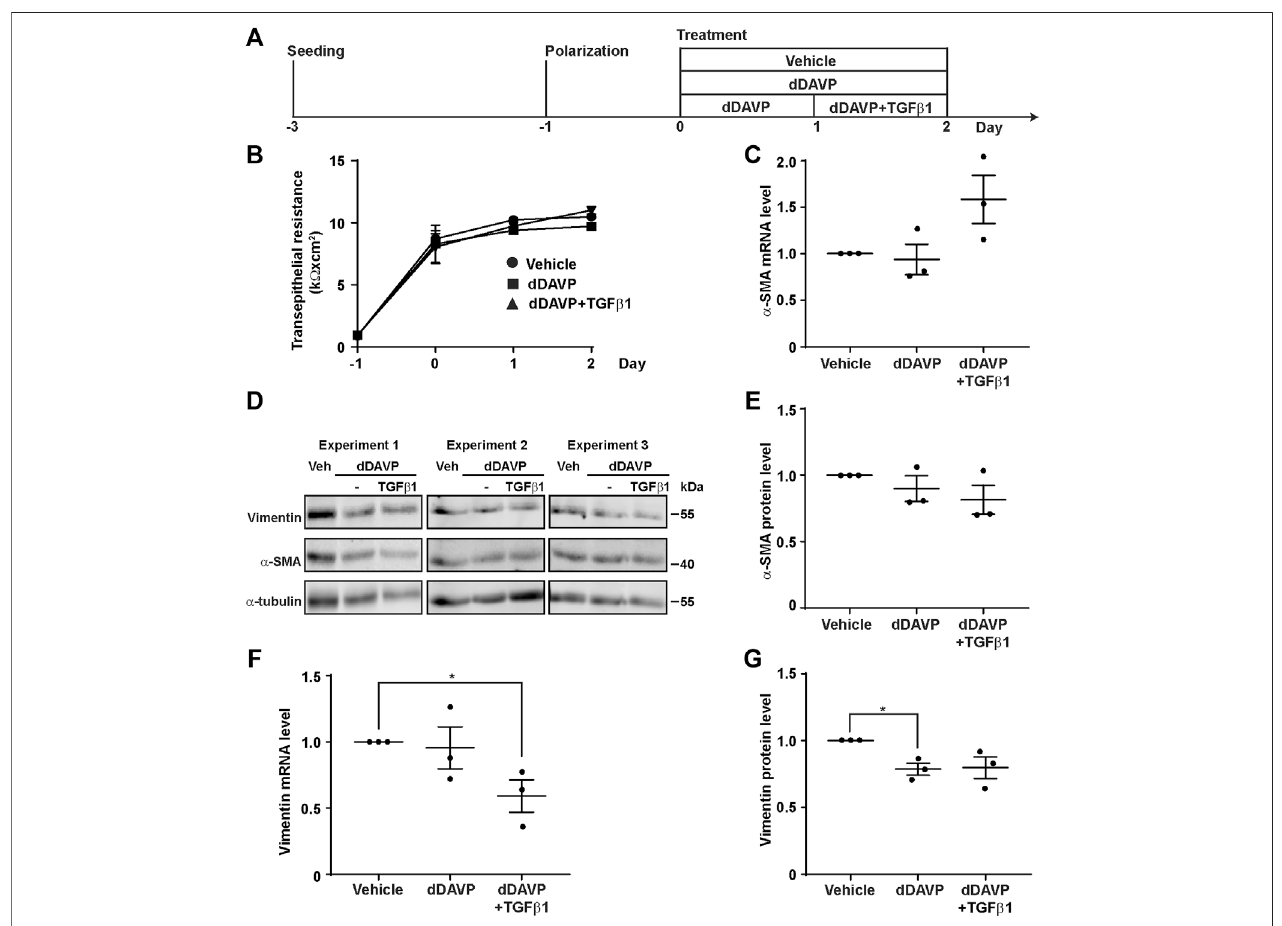
FIGURE 6 | TGF β 1did not induce epithelial-to-mesenchymal transition. (A) Experimental protocol. (B) Transepithelial electrical resistance of mpkCCD cells grown onTranswell ® membraneunderthevehicle,dDAVP(1 nM),ordDAVP+TGF β 1(10 ng/ml)conditions. (C,F) QuantitativeRT-PCRmeasurementsof α -SMAandvimentin mRNA levels in the mpkCCD cells under the same conditions. (D) Immunoblots and (E,G) summaries ofimmunoblotting results for α -SMA and vimentin protein levels in the cells under the same conditions. Values are mean ± S. E. summarized from three independent experiments. Values were normalized with loading control ( α - tubulin) before being compared against those under the vehicle conditions. Asterisks indicate statistical signi fi cance ( p < 0.05, t -test).